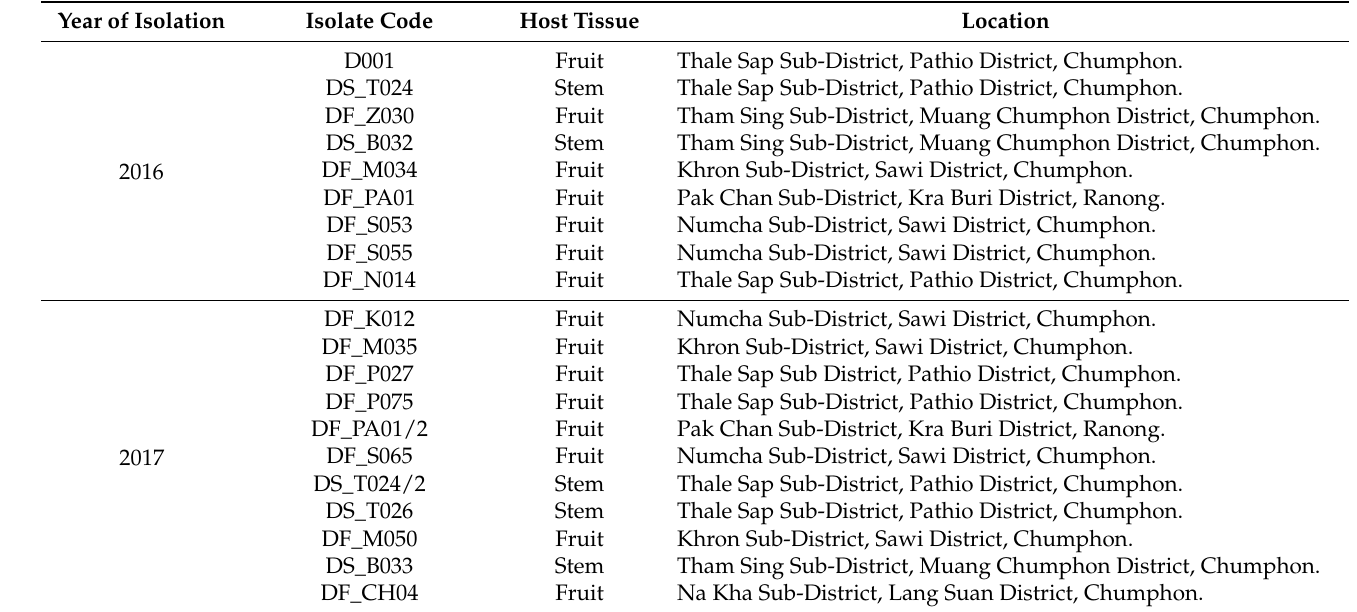
Table 1. Sources of Phytophthora isolates used in this